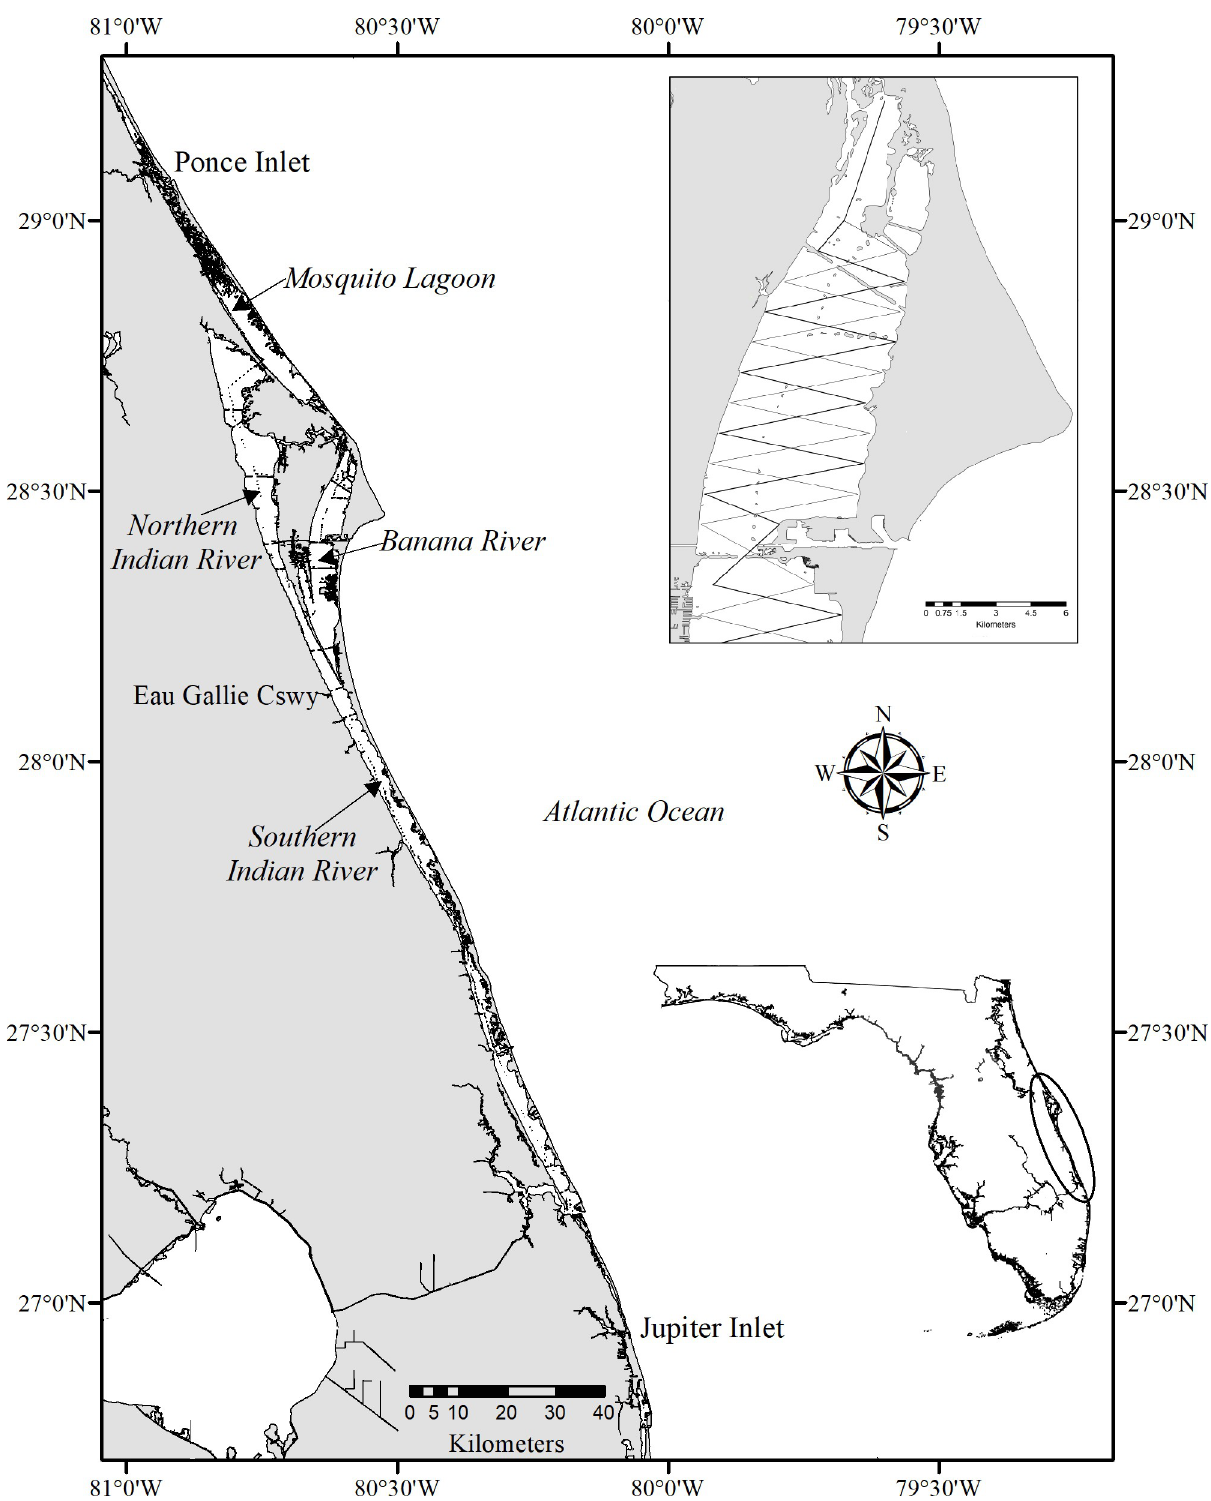
Fig 1. Map of the Indian River Lagoon (Ponce Inlet to Jupiter Inlet; insert lower right) along the east coast of Florida. Sub-basins aligned N-S are: Mosquito Lagoon; Banana River; northern Indian River; southern Indian River. Contour lines and alternating saw-tooth transects were utilized throughout the lagoon as illustrated in the inset portion of the Banana River (upper right). The map was generated using ERSI software, ArcGIS 10.8 (http://www.esri.com/software/argis), using geographic data from Florida Fish and Wildlife Conservation Commission. Reprinted from [Florida Fish